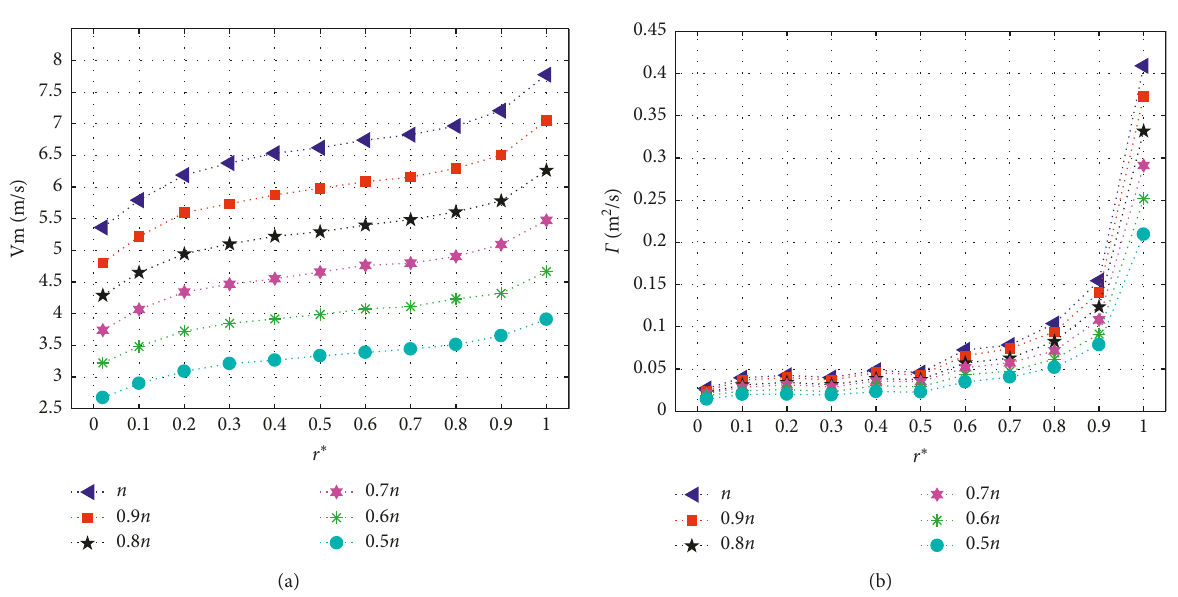
Figure 13: Velocity of the blade inlet section. (a) Axial velocity. (b) Velocity